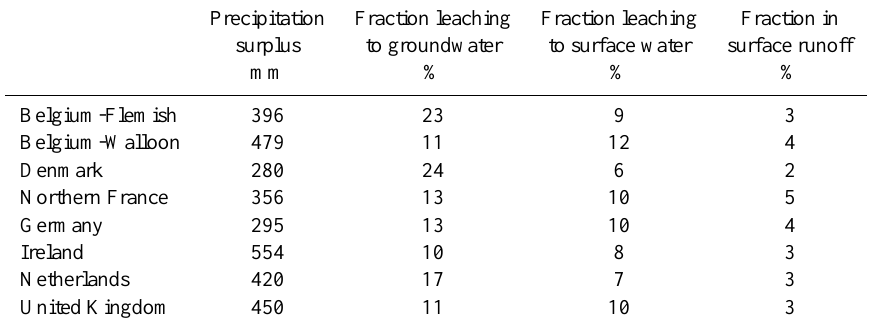
Table 2. Precipitation surplus and fraction of nitrogen surplus leaching to groundwater, the fraction leaching to surface waters and the runoff fraction of N in applied fertilizer, grazing and manure, used in the MITERRA model. Precipitation Fraction leaching Fraction leaching Fraction in surplus to groundwater to surface water surface runoff mm % % % Belgium-Flemish 396 23 9 Belgium-Walloon 479 11 Denmark Northern